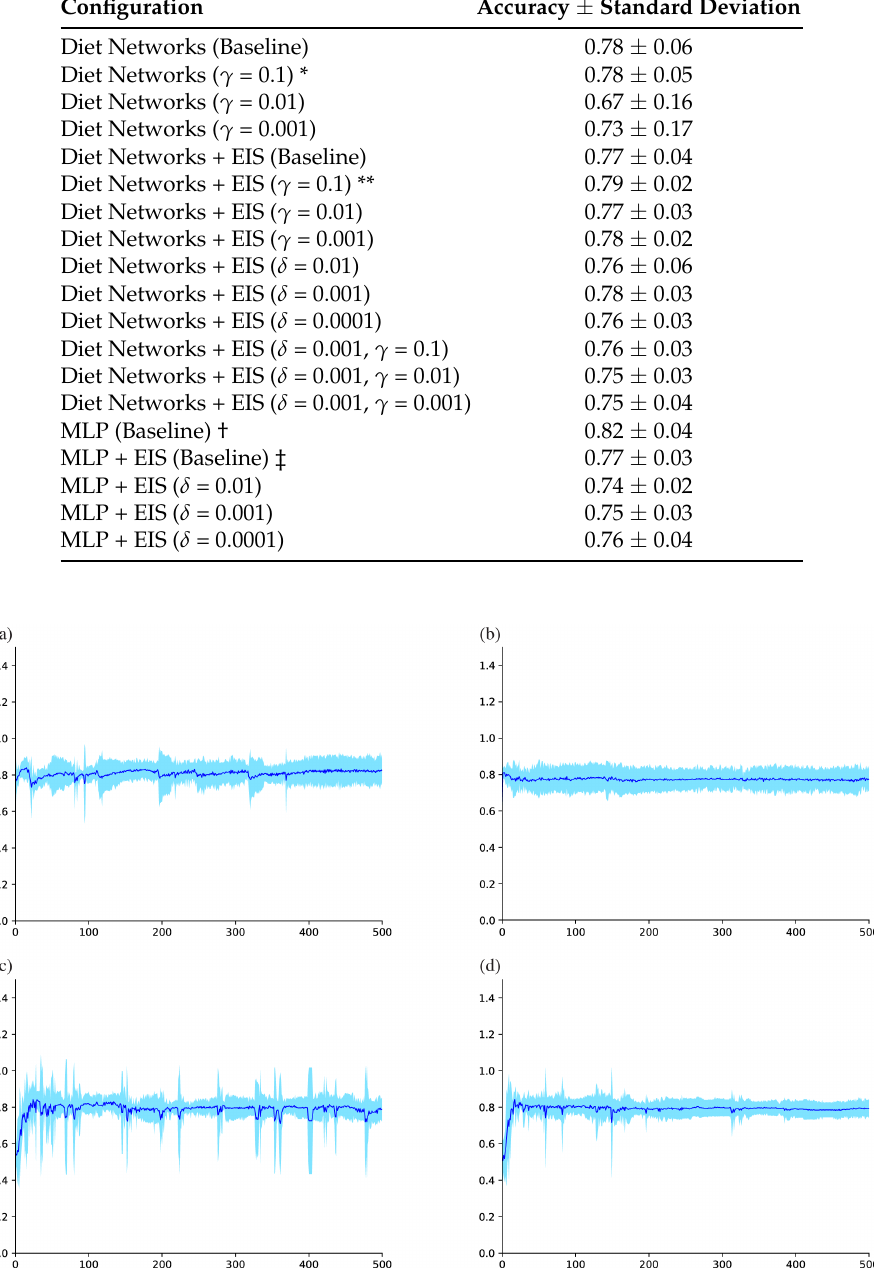
Figure 2. Training curve showing validation accuracy for each model during a short period between epochs 1 and 500: ( a ) multilayer perceptron (MLP) (baseline), ( b ) MLP with element-wise input scaling (EIS) (baseline), ( c ) Diet Networks ( γ = 0.1), and ( d ) Diet Networks with EIS ( γ = 0.1). Note that a relatively broad range of variance appeared in the training curve of Diet Networks ( γ = 0.1). Vertical axis and horizontal axis indicate accuracy mean ± standard deviation and number of epochs,